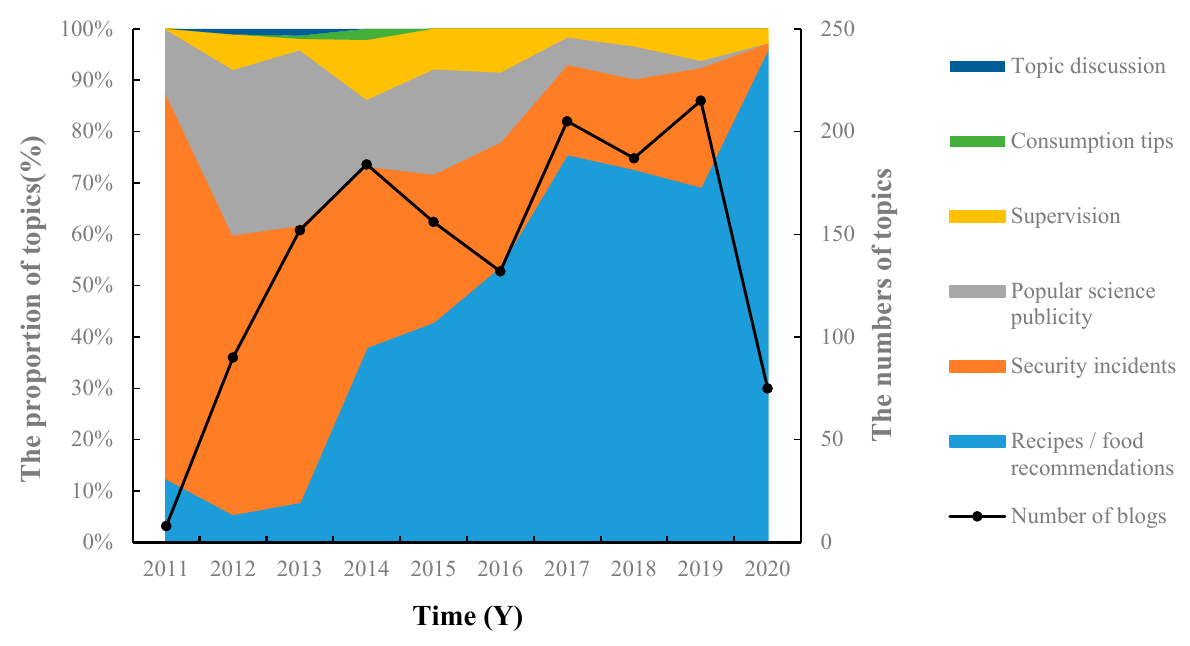
Figure 5. Trends in consumer concerns about food additive-related topics from 2011 to 2020.